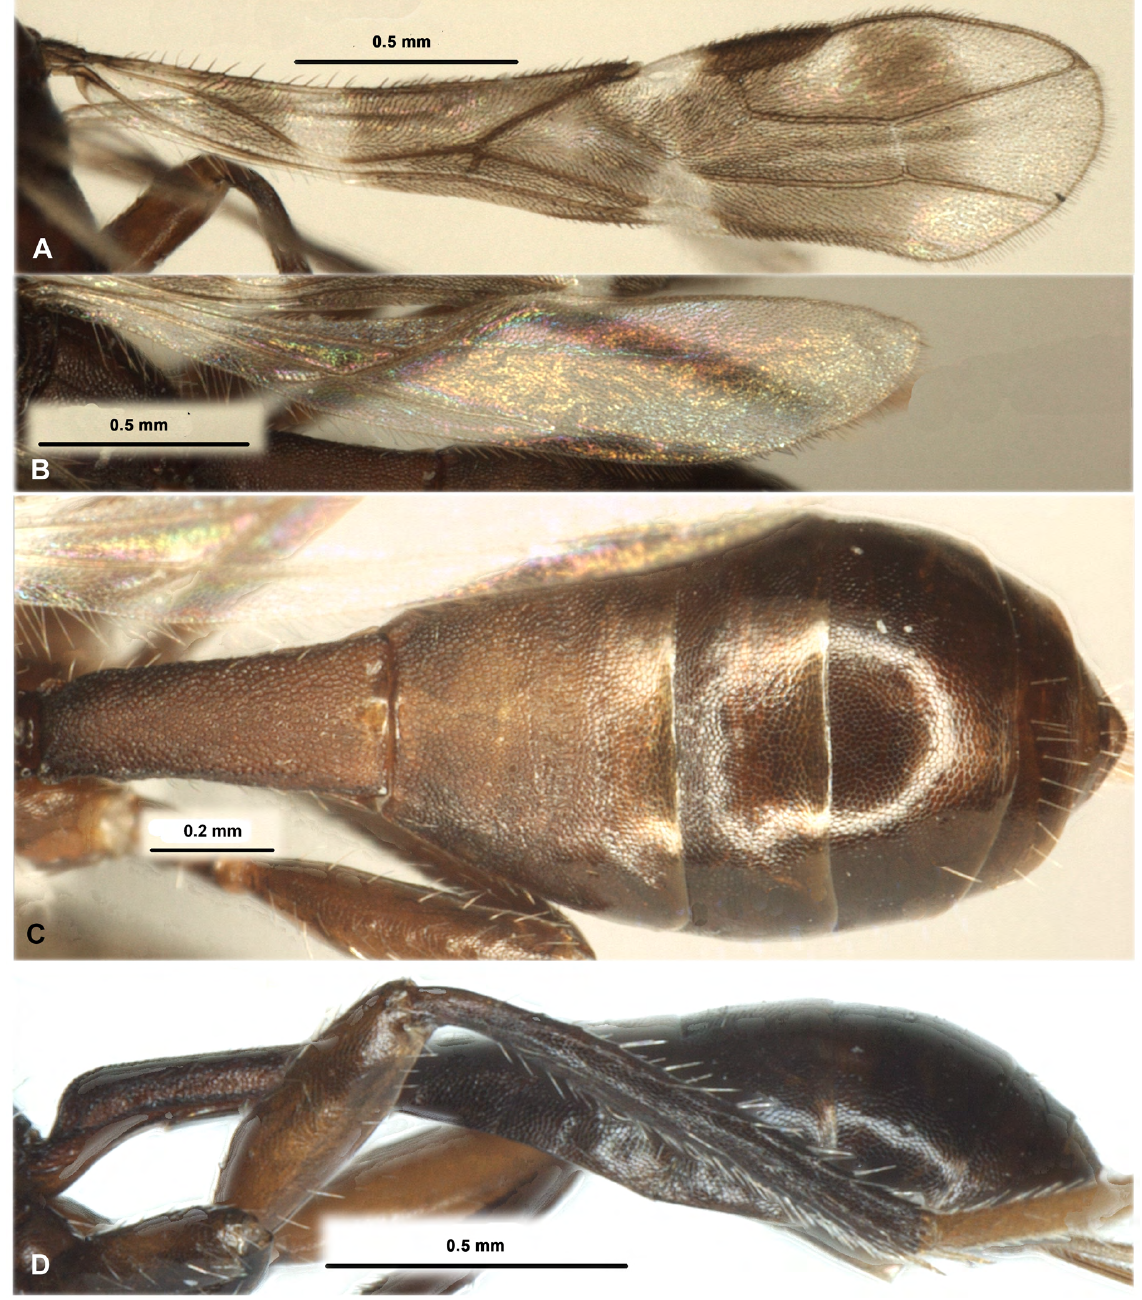
Fig. 33. Platyspathius ( Platyspathius ) ornatulus Enderlein, 1912, ♀, lectotype, MIZW. A . Fore wing. B . Hind wing, C . Metasoma, dorsal view. D . Metasoma, lateral